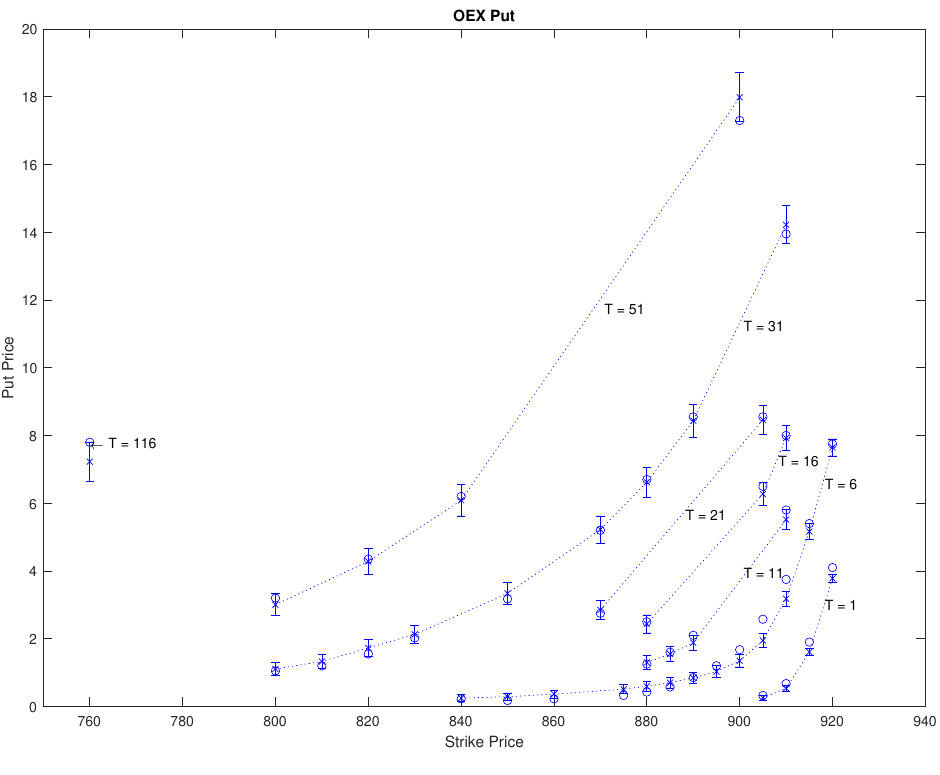
Figure 7. OEX put prices on April 6, 2016 and LSM prices with their confidence intervals. Circles (‘ ◦ ’) are observed OEX put prices, ‘ × ’ points are LMS prices, and ‘I’ shape bars are 95% confidence intervals of LMS